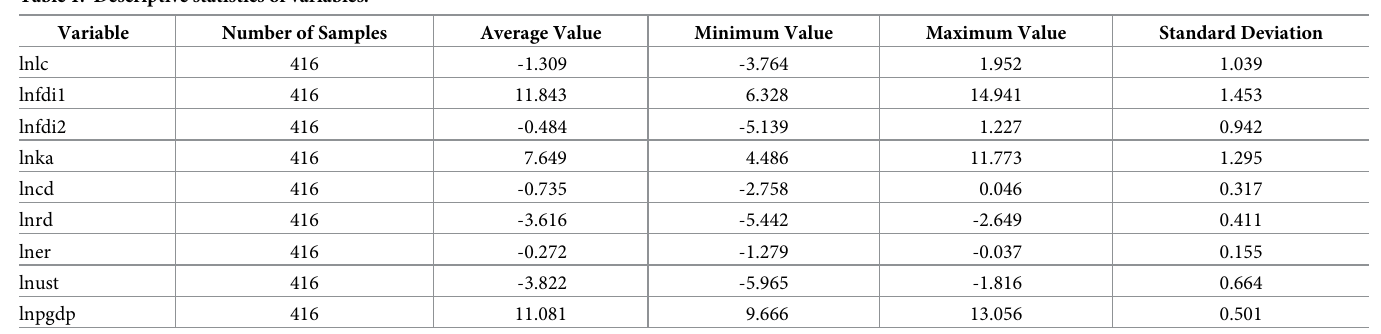
Table 1. Descriptive statistics of variables.